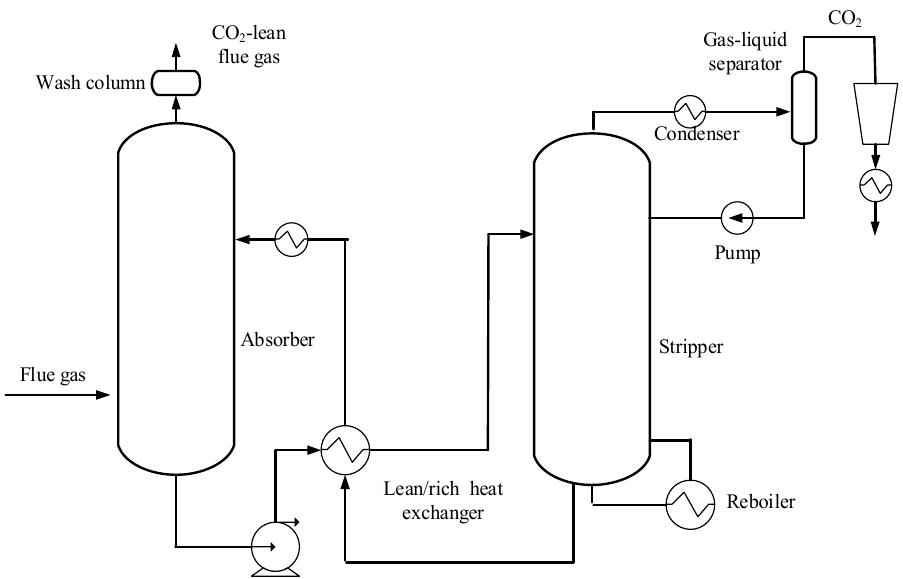
Figure 1. Monoethanolamine-based post-combustion CO 2 capture process.